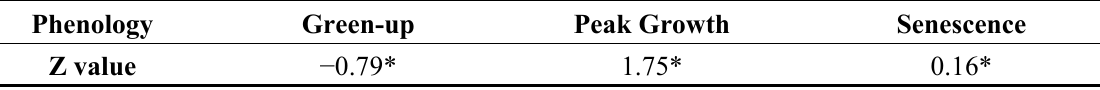
Table 2. The trends of green-up, peak growth, and senescence indicated by the Z values during the period of 1985–2007 in